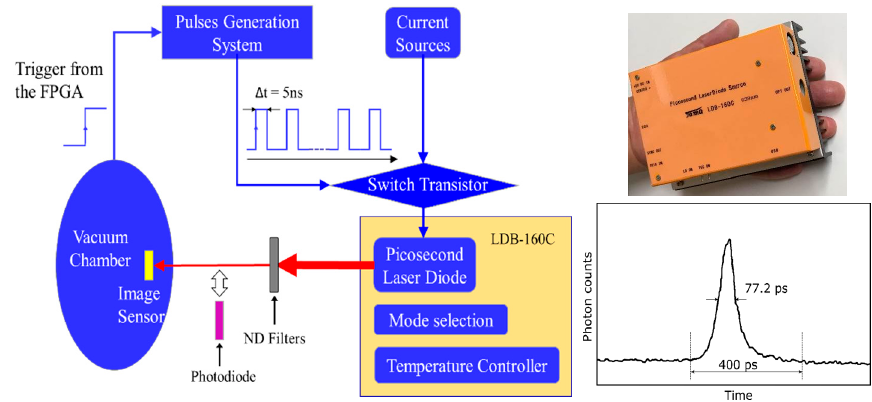
Figure 3. The imaging system and the LD ( λ = 639 nm) used in evaluation of the temporal resolution.